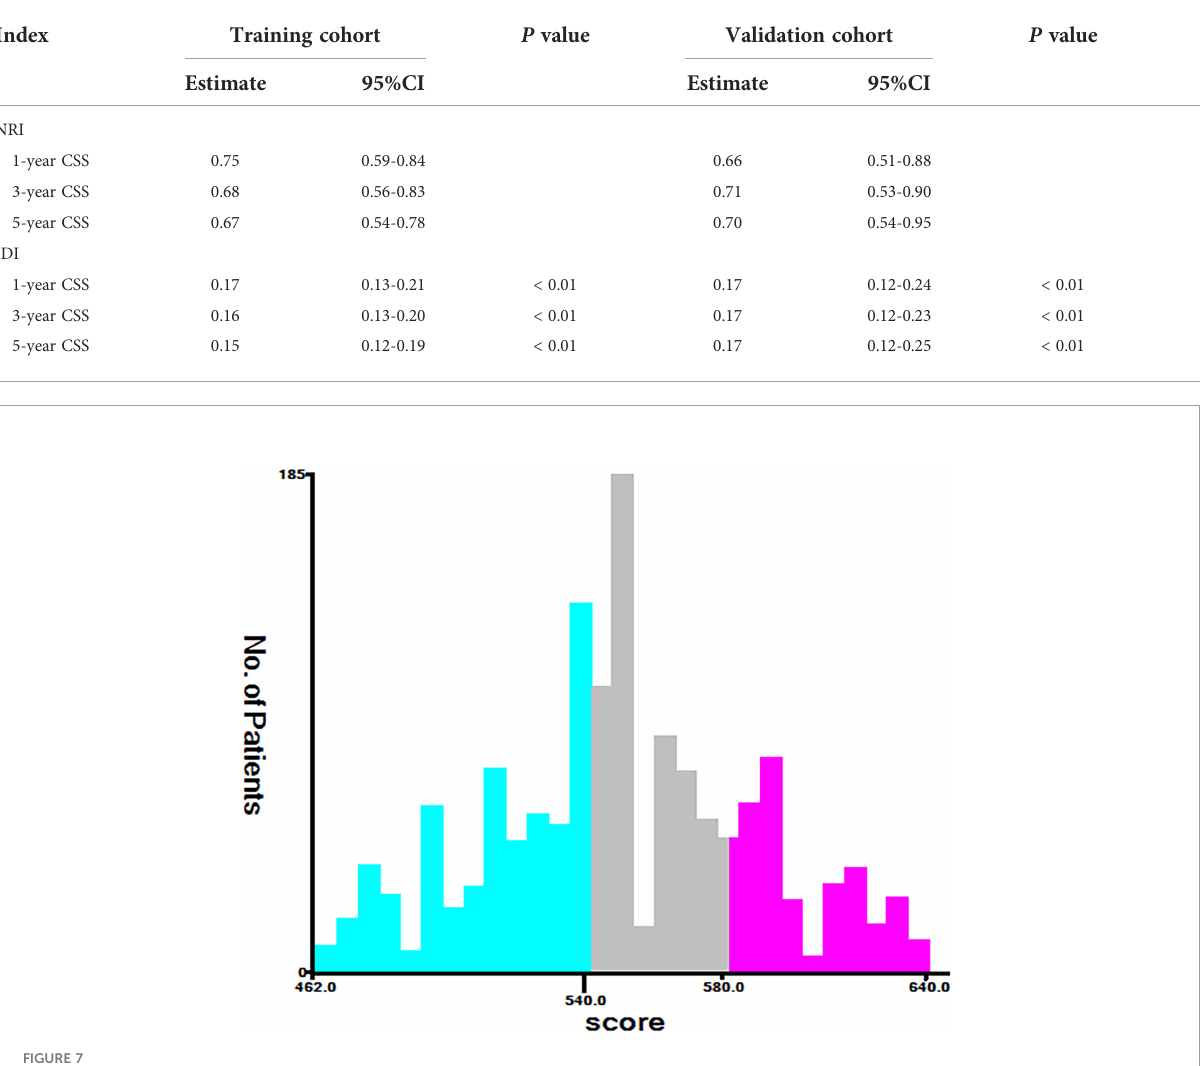
TABLE 3 NRI and IDI to evaluate the predictive power of the model.